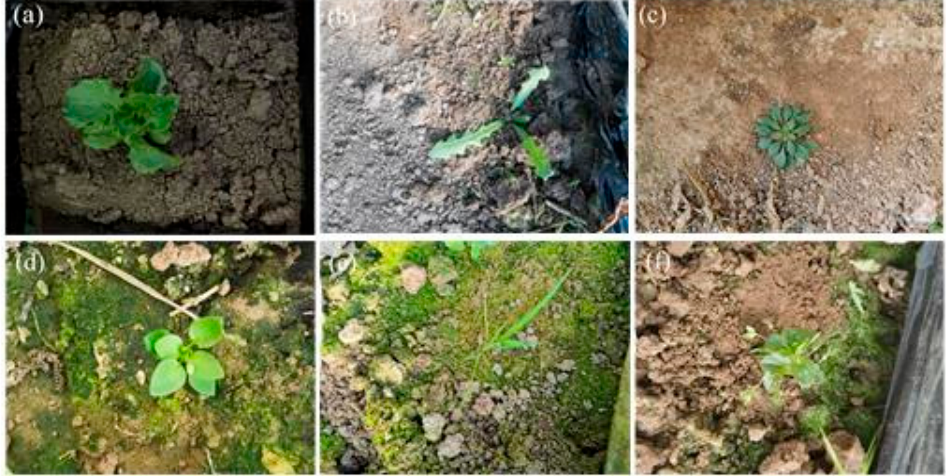
Figure 1. Examples of lettuce and weed images. ( a ) An example of lettuce, ( b ) an example of Sonchus Brachyotus (SB), ( c ) an example of Asiatic Plantain (AP), ( d ) an example of Malachium Aquaticum (MA), ( e ) an example of Wild Oats (WO), and ( f ) an example of Geminate Speedwell (GS).